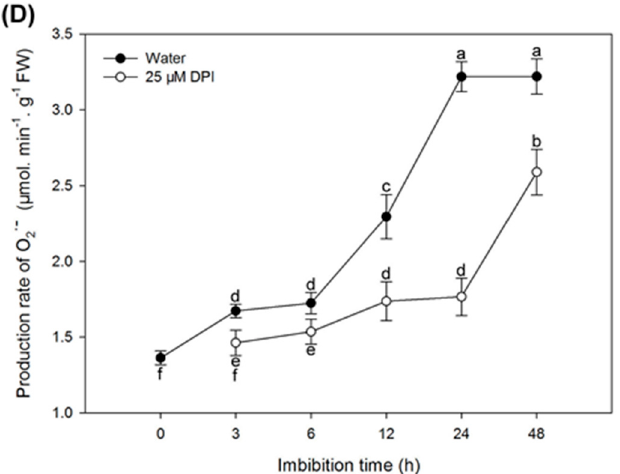
Figure 3. Histochemical staining and quantification of O 2 − in rice seeds incubated in water or with DPI. ( A ) Schematic model for reactive oxygen species (ROS) generation by NADPH oxidases. SOD, superoxide dismutase. POD, peroxidase; ( B , C ) Histochemical staining by nitrobluetetrazolium (NBT) to determine the localization of O 2 − in whole seeds incubated in water or with 25 μ M DPI for 3, 6, 12, 24, 48 h and half granule seeds with embryo for 24 h, respectively. Scale bar, 1000 μ m; ( D ) Quantification of the O 2 − production rate in rice seeds incubated in water or with 25 μ M DPI for 0, 3, 6, 12, 24 or 48 h. Data represent the mean ± SE of three biological replicates of 30 embryos (~0.1 g) each. Means denoted by the same letter do not significantly differ at p < 0.05 (Fisher’s least significant difference test). FW, fresh weight.